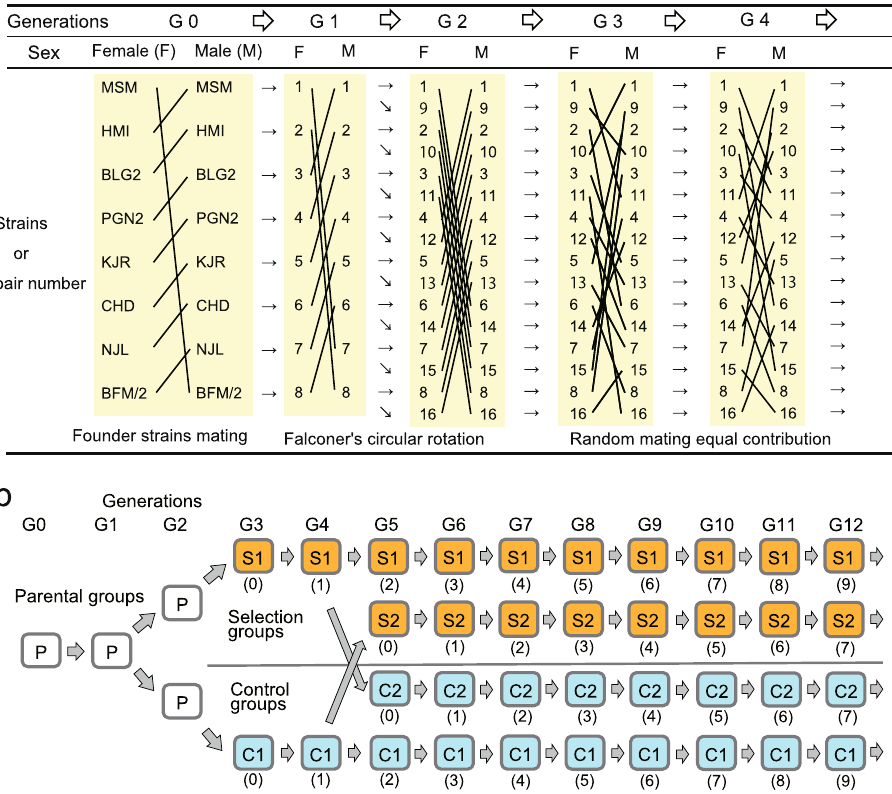
Figure 2. Mating design used to establish the wild-derived heterogeneous stock (WHS) and for selective breeding. ( a ) Mating scheme for the early stage of establishing the WHS. Lines between founder strains and numbers indicate matings to produce progeny. The cage numbers for the next generations are given for the female lineage, so both male and female progeny were given the same cage numbers as their mothers, except for in generation G 1 , in which the number for each female founder strain is given. At generation zero (G 0 ), a male mouse of one of the eight wild strains was mated with a female of another wild strain to produce G 1 mice following the circular rotation rule (see Methods). For example, a female from the MSM strain (no.1) was mated with a male from the BFM/2 strain (no. 8). A male G 1 mouse from one pair was mated with a female G 1 from another pair following the circular rotation rule, so a female produced by no. 1 was mated with a male produced by no. 7, a female produced by no. 2 was mated with a male produced by no. 8, etc. At the G 2 generation, the number of pairs was expanded from eight to 16, and the mice were mated again following the rotation rule. From the G 3 generation, mating pairs were made following the random mating rule while avoiding intercrossing. ( b ) The process used to establish the two selection groups S1 and S2 and the two control groups C1 and C2. Each number in parentheses indicates the number of selections (see Methods). The orange and blue boxes indicate selection and control groups,